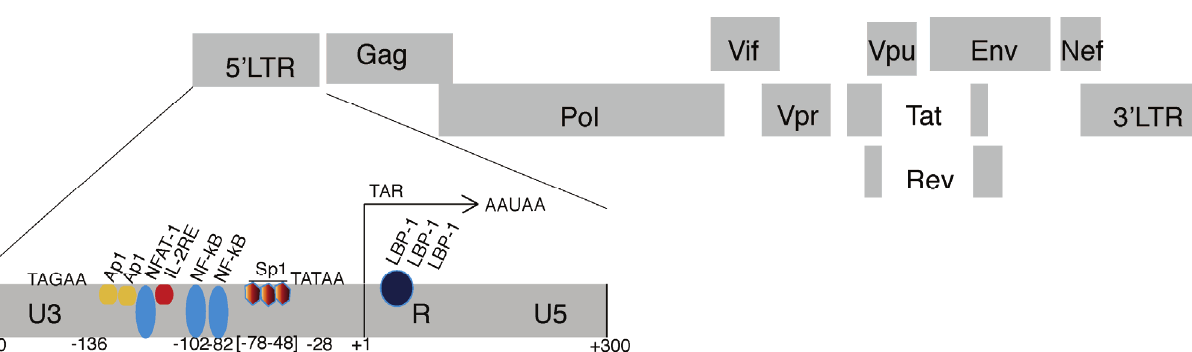
Figure 1. The LTR promoter of HIV. The genomic organization of HIV-1 is shown with lines emphasizing/delineating the 5' LTR/promoter. The transcription factor AP1, NFAT-1, IL-2RE, NF-kB, Sp1 and LBP-1 binding sites, TATA box, upstream weak transcriptional start TAGAA, Tat activating region (TAR), and the AAUAA poly-adenylation sites downstream of TAR in the LTR are shown. Note not all transcription factor binding sites are